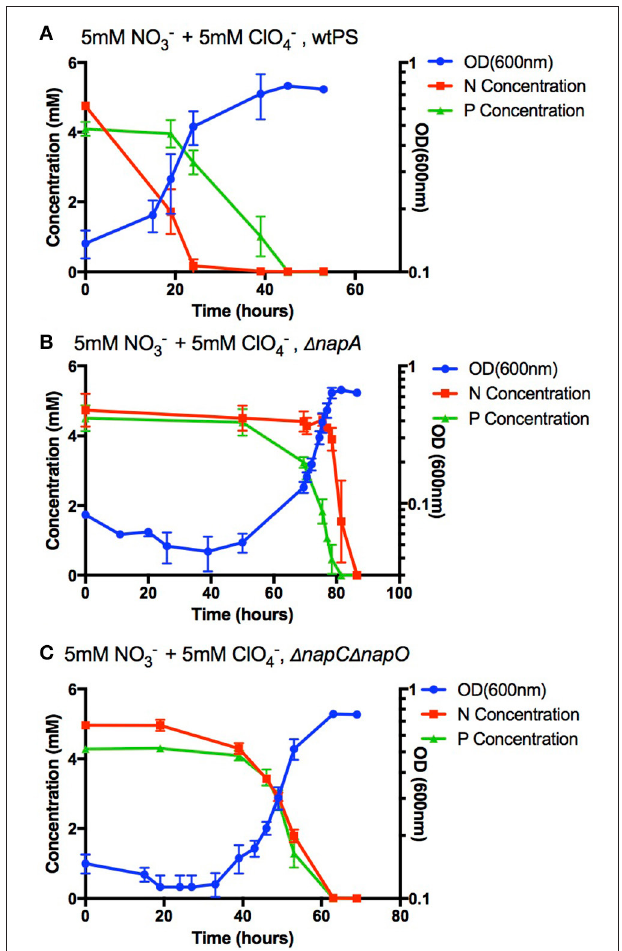
FIGURE 5 | Growth and concentration of nitrate or perchlorate in cultures of wtPS (A) , ∆ napA (B) , and ∆ napC ∆ napO (C) , in LMM medium with 5mM nitrate and 5mM perchlorate. Error bars represent standard deviations of biological triplicate